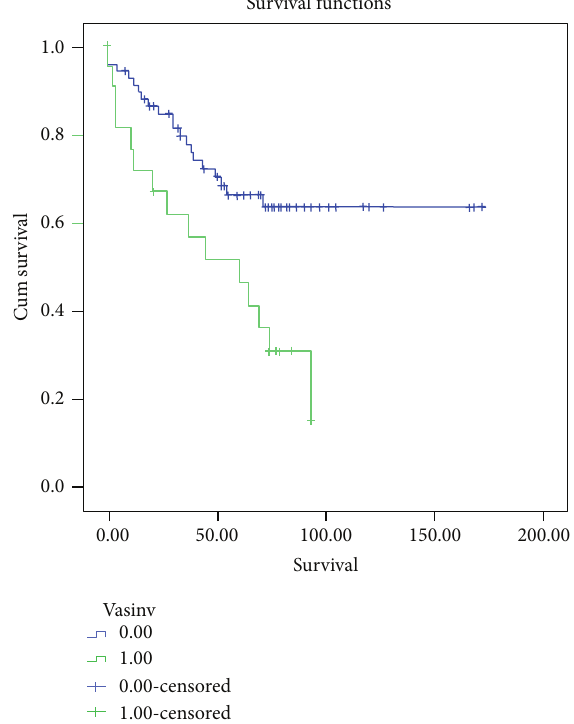
Figure 1: This graphic shows survival among patients undergoing LT with and without vascular invasion. Survival is significantly better in those patients transplanted without vascular invasion ( 𝑃 < 0.05